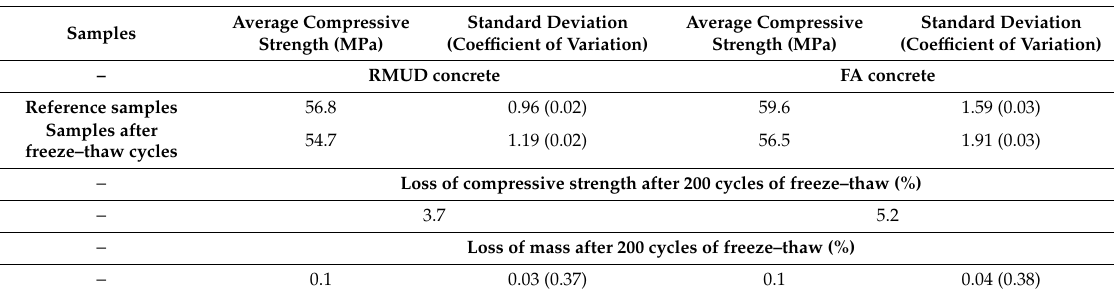
Table 6. Results of freeze–thaw tests (200 cycles)